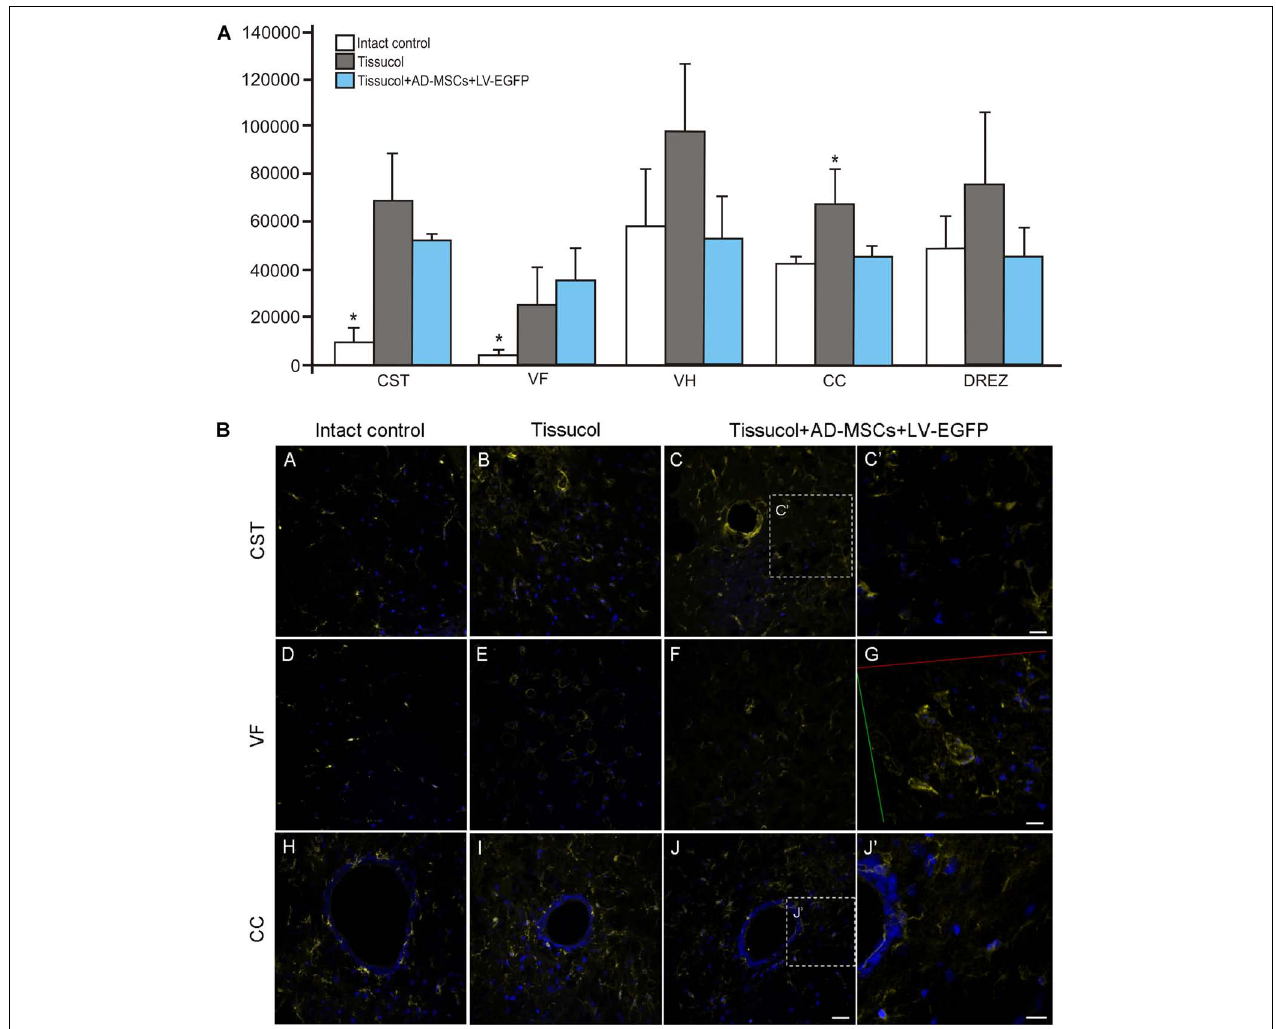
FIGURE 4 | Assessment of microglial cells at the site of injury. (A) The mean intensity of Iba1 (Y axis) in intact spinal cord (write column) or 60 days after Tissucol (gray column) and Tissucol+AD-MSCs+LV-EGFP (blue column) application within the examined regions. ∗ P < 0.05, one-way ANOVA followed by a Tukey’s post hoc test. (B) Assessment of microglial cells with Iba1 (yellow) 5 mm caudally from the injury epicenter within the CST, VF, and CC in the investigated groups. Nuclei are DAPI-stained (blue). Dashed boxed areas in C, J are shown in C (cid:48) ,J (cid:48) . G show 3D confocal microscopy image in VF of Tissucol+AD-MSCs+LV-EGFP group. Scale bar: 25 (A–J) and 10 (C (cid:48) ,G,J (cid:48) ) µ